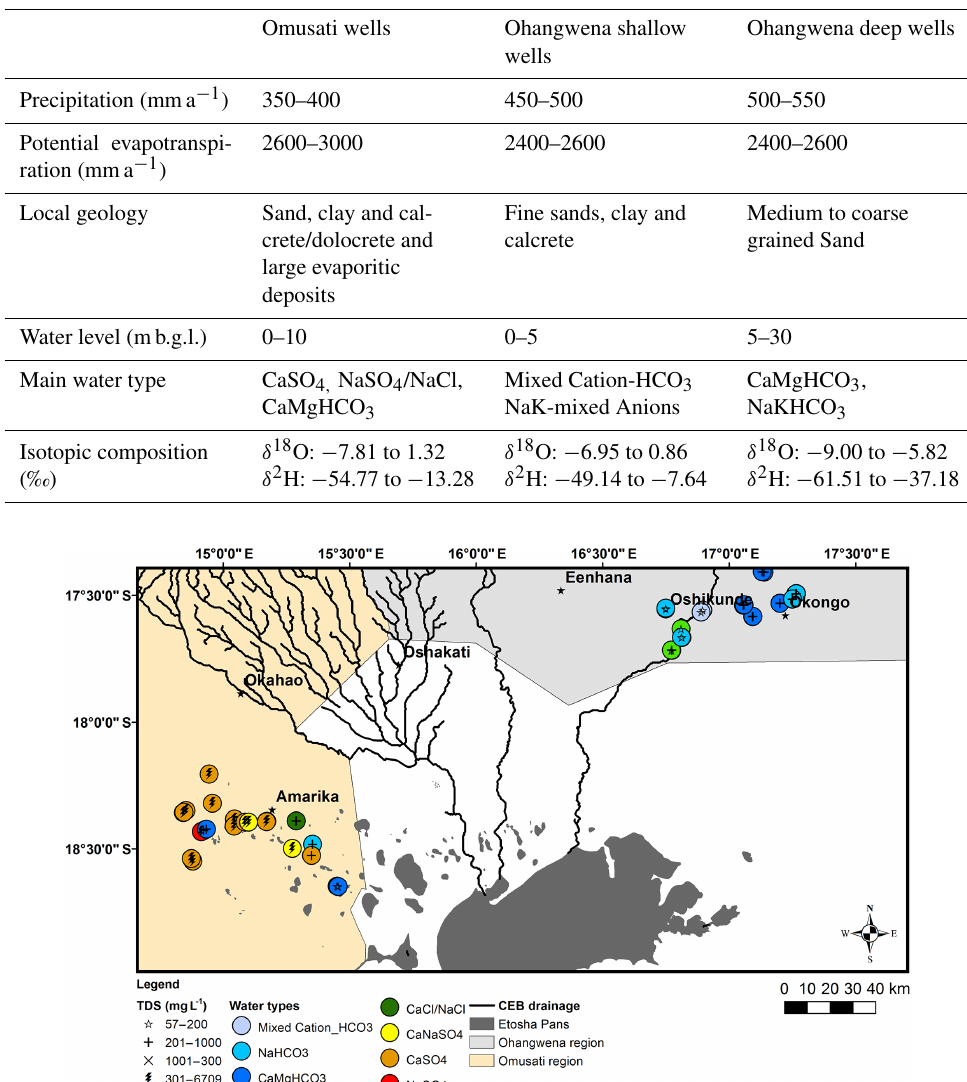
Table 1. Comparison of the two core sites and main results. Source for climate data Mendelsohn et al. (2013).